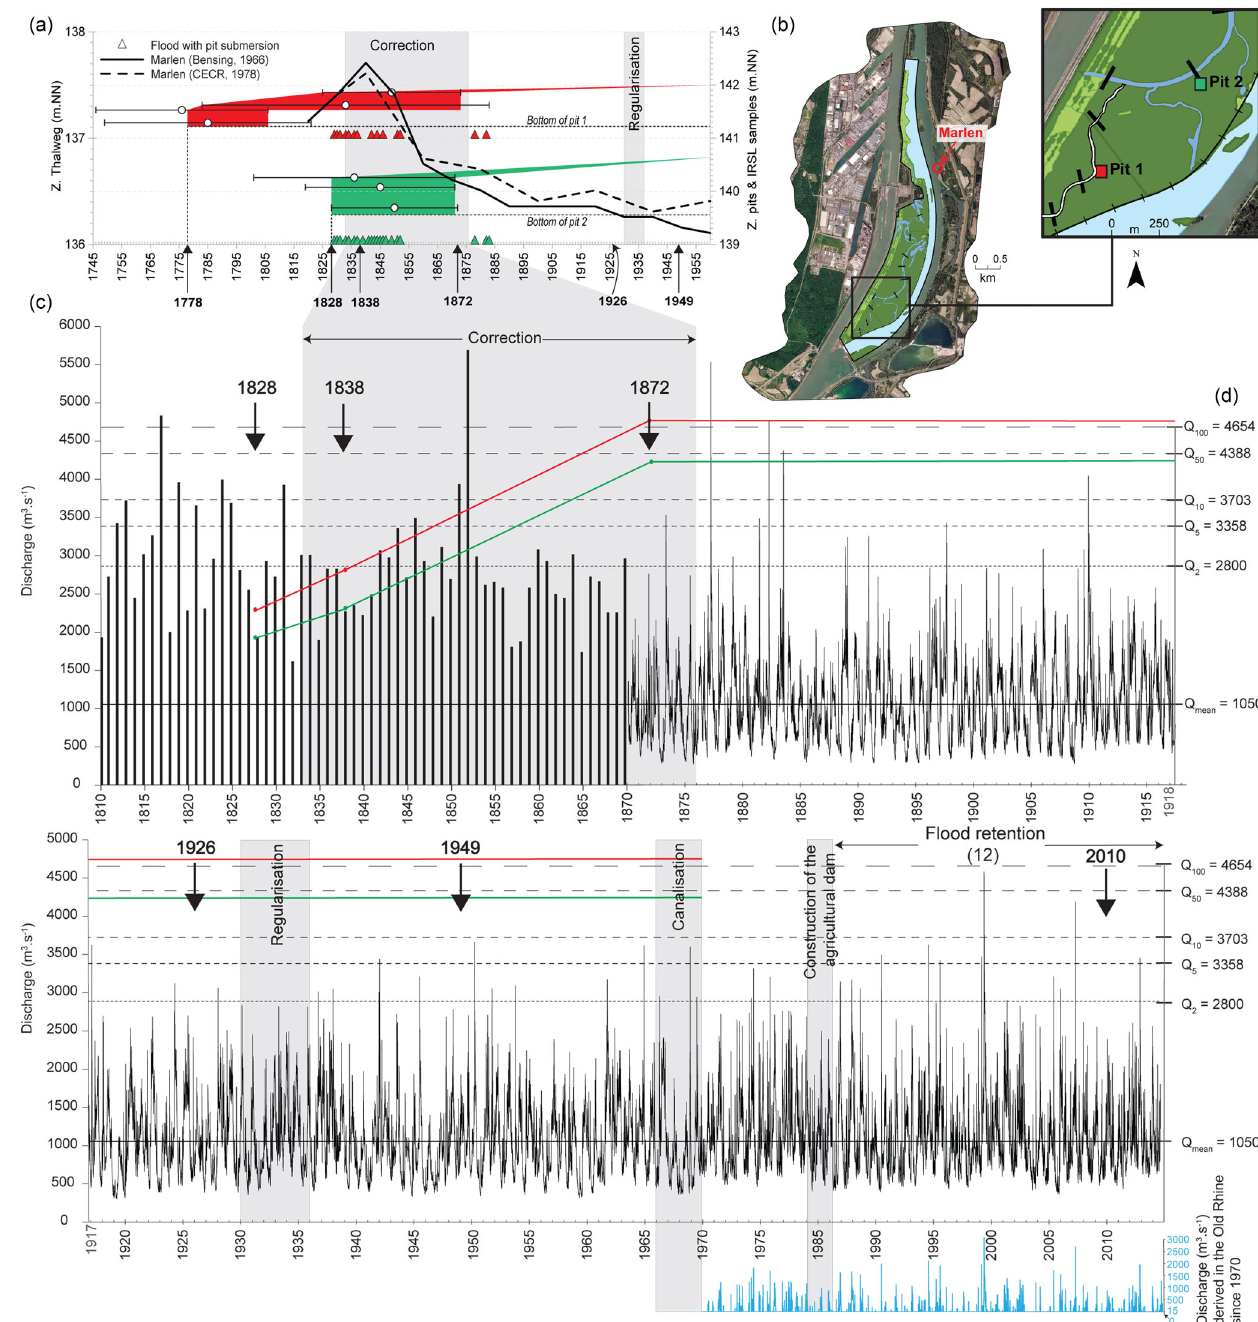
Figure 5. (a) Vertical evolution of the Rhine thalweg from 1815 to 1960 based on low water levels ( Q ∼ 540m 3 s − 1 ) recorded at the Marlen gauging station (Bull, 1885; Bensing, 1966; CECR, 1978). Vertical evolution of the pits linked to the age–depth model and number of floods which attained each pit (triangle), (b) location of the two pits and of the ancient gauging station of Marlen, and (c) discharge of the Rhine at the gauging station of Basel. The period 1810–1870 corresponds to maximum instantaneous annual flows. The period 1870–2015 corresponds to the highest mean daily flow (OFEV: Office Fédéral de l’EnVironnement). The dates with arrows correspond to old maps or aerial photographs (see Fig. 4). The red and green lines correspond to the submersion discharges for pits 1 and 2, respectively. (d) Flood return periods at Basel between 1870 and 2015 (m 3 s − 1 ; adjustment of Pearson III,